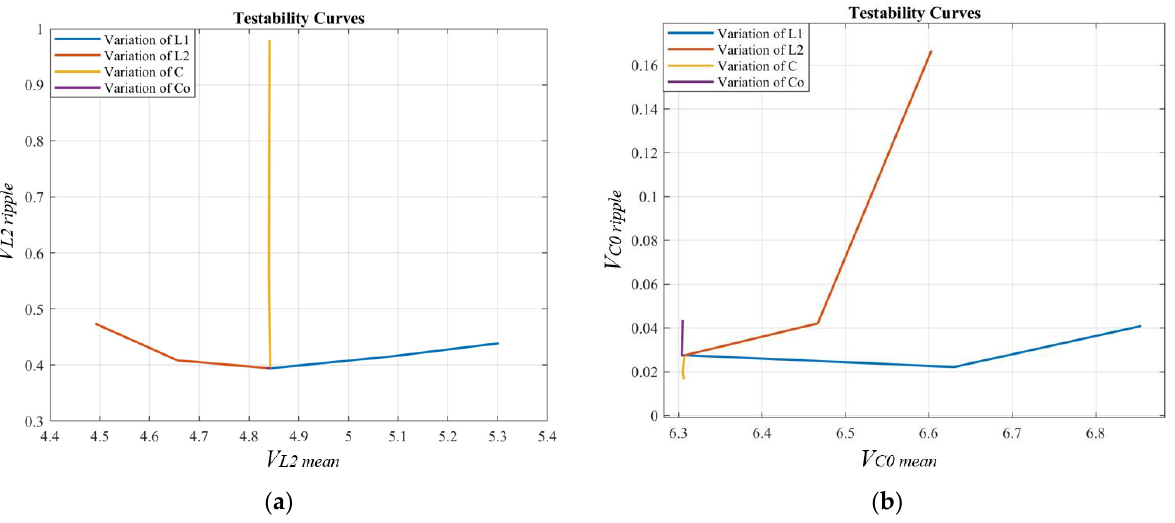
Figure 18. Testability assessment for SEPIC converter in CCM during the switch-on period: ( a ) voltage across L 2 ( b ) voltage across C 0 .